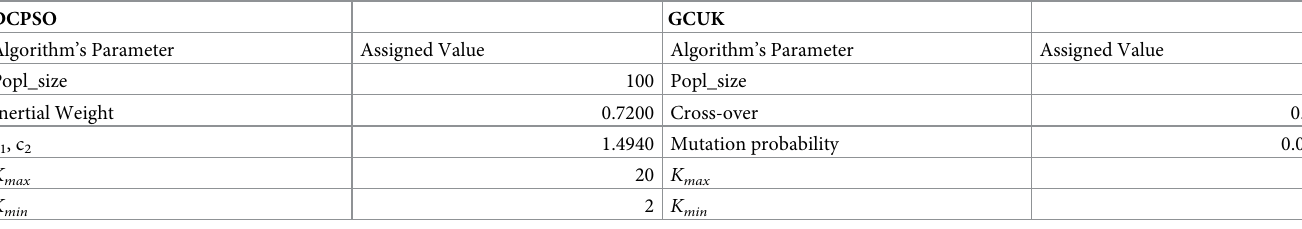
Table 3. Initial parameter setting for the compared algorithms. DCPSO Algorithm’s